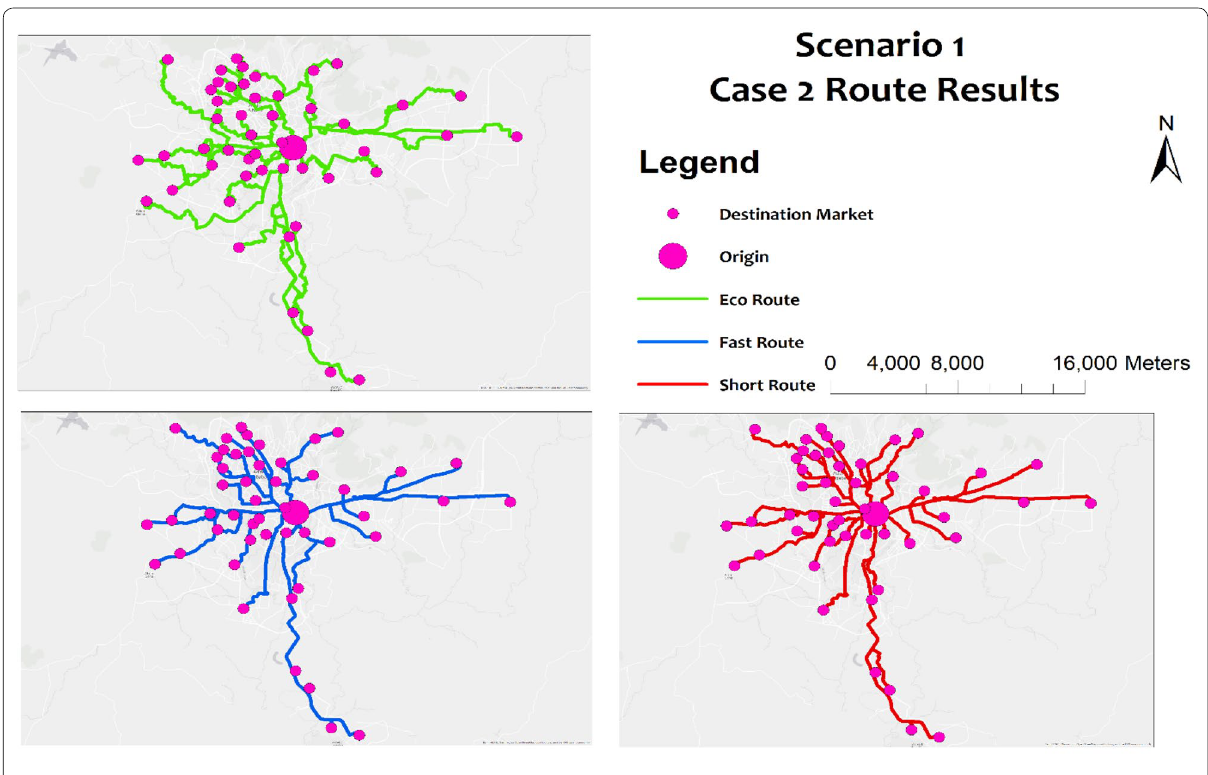
Fig. 6 Scenario 1 Case 2